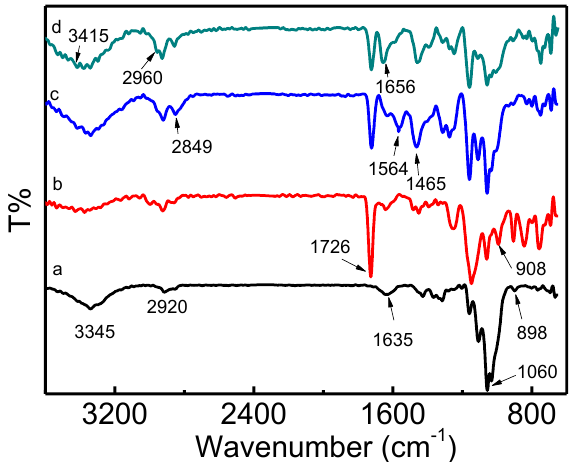
Figure 3. FT-IR spectra of original cotton linter (a), grafted cotton linter fiber (CLF-g-GMA) (b), CLF-g-GMA-Pentaethylene hexamine (PEHA) (c) and QCLF (d).